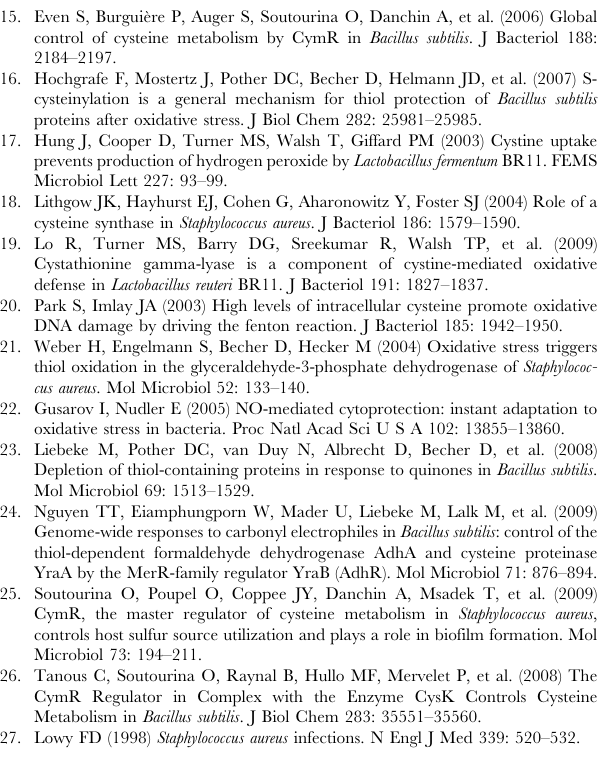
Figure S2 Cystine effect on stress resistance phenotypes of S. aureus mutant strains. Disk diffusion assays were performed with 200 mM tellurite K 2 TeO 3 (A) or 200 mM CuSO 4 (B) in TSB medium with (white) and without (grey) 2 mM cystine. Results represent the mean values with standard deviations and are representative of at least three independent experiments.